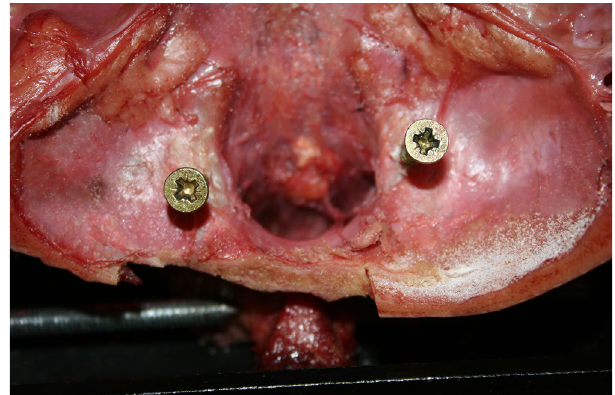
Figure 2. Screw stabilization of occipital-atlas (C0–C1)